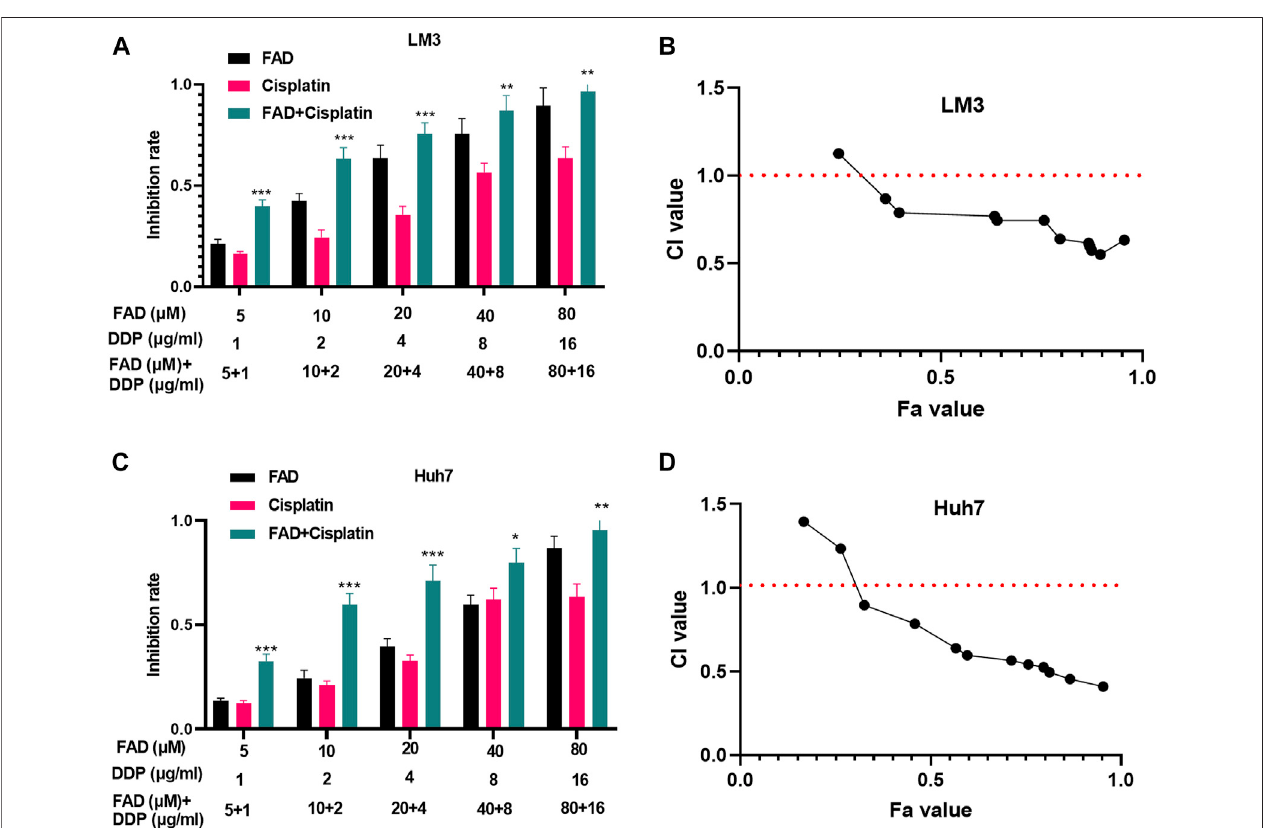
FIGURE3| FADhadasynergisticeffectwithDDPinHCCcells.HCCcelllines(Huh7andLM3)weretreatedwithFAD(5,10,20,and40.80 µM)withorwithoutDDP (1, 2,4, 8, and 16 μ g) for 24 h. (A, C) . The inhibition rate of Huh7 and LM3 cells under FAD/DDP treatment was measured via CCK8 assay. *, **, *** represents p < 0.05, p < 0.01, p < 0.001 (vs. DDP group), respectively. (B, D) . The synergistic effect of FAD and DDP were measured using the Median-effect principle, and the fa-CI curve graph of the two cell lines was shown. N (cid:2) 3. All experiments were repeated three